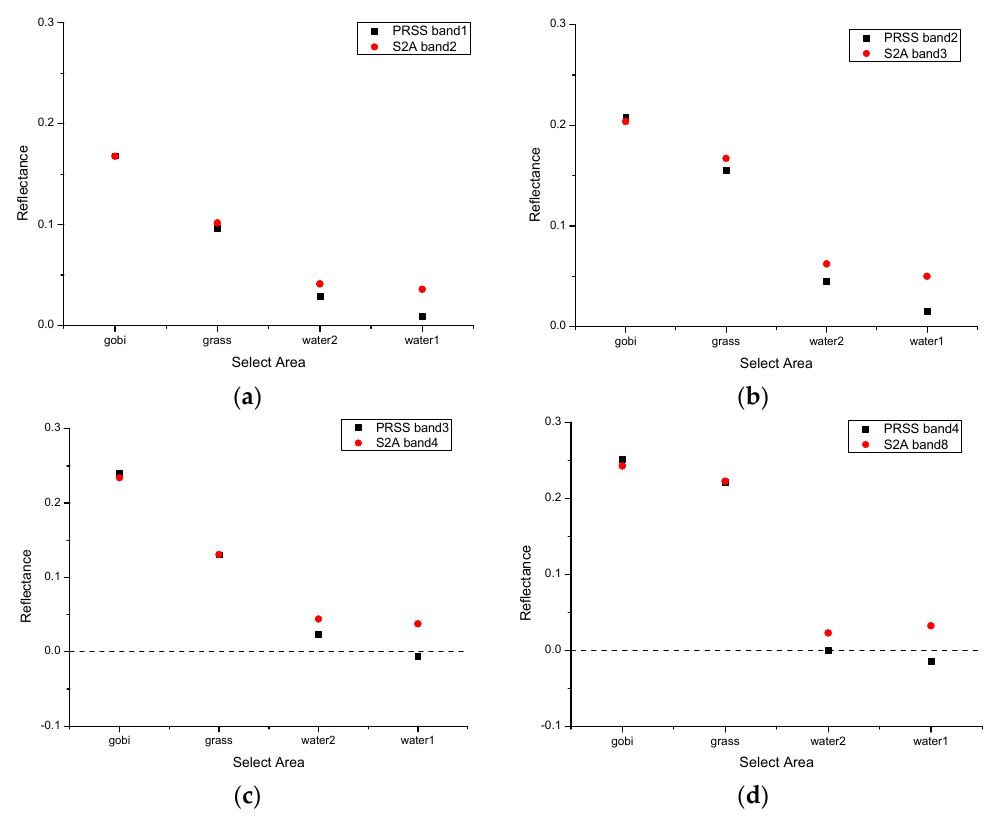
Figure 14. Comparison of ground reflectance in different areas obtained by PRSS-1 using RCRII model and Sentinel-2 using reflectance inversion model; ( a – d ) show blue, green, red, and NIR bands.